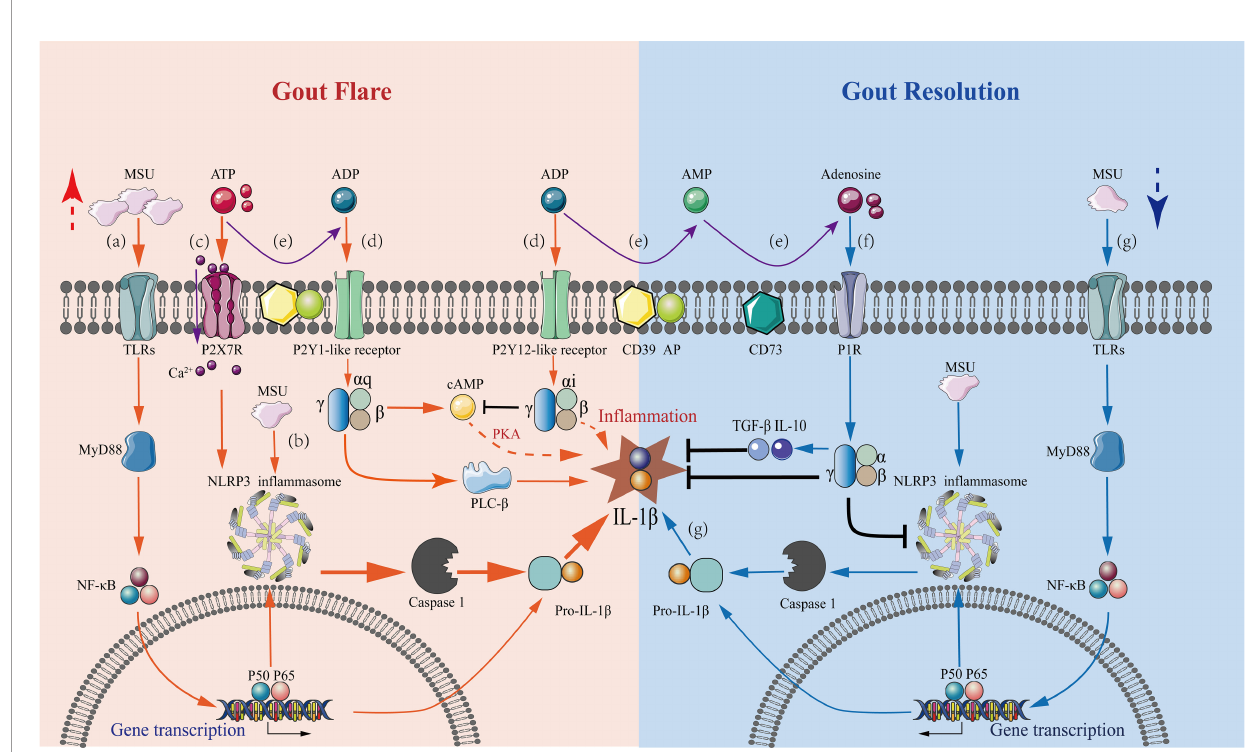
FIGURE 1 | Mechanisms underlying purinergic signaling pathways in the regulation of gout fl ares and resolution. A series of purinergic receptor-mediated intracellular signaling events in macrophages are involved in gout fl are and resolution, with the regulation of IL-1 b levels being a central event. Gout fl